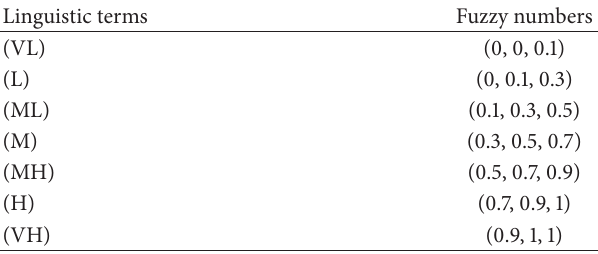
Table 1: Linguistic terms and related fuzzy numbers for weight of preference.